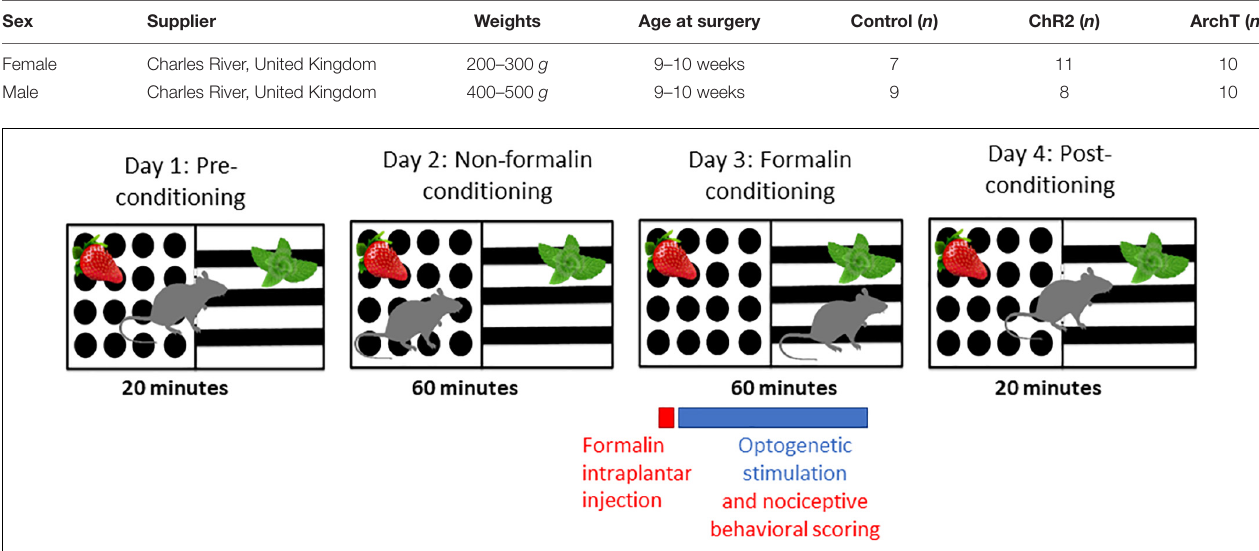
FIGURE 1 | Schematic of F-CPA apparatus and behavioral testing